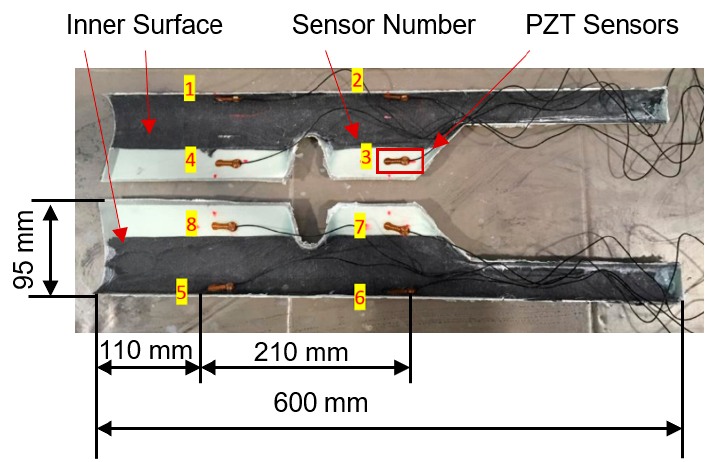
Figure 12. PZT sensors attached to the curved supporting structure. Table 3. Parameters of the PZT sensor.